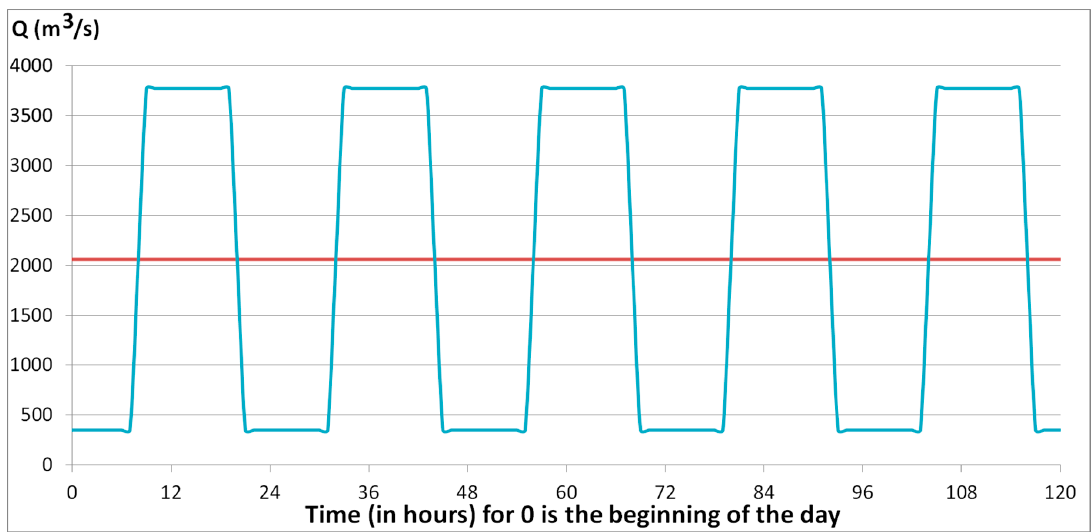
Figure 2. Change in the discharge flow rate of water from the Kamskaya Hydroelectric Power Plant (HEPP) and the flow rate of water inflow into the Kama reservoir.